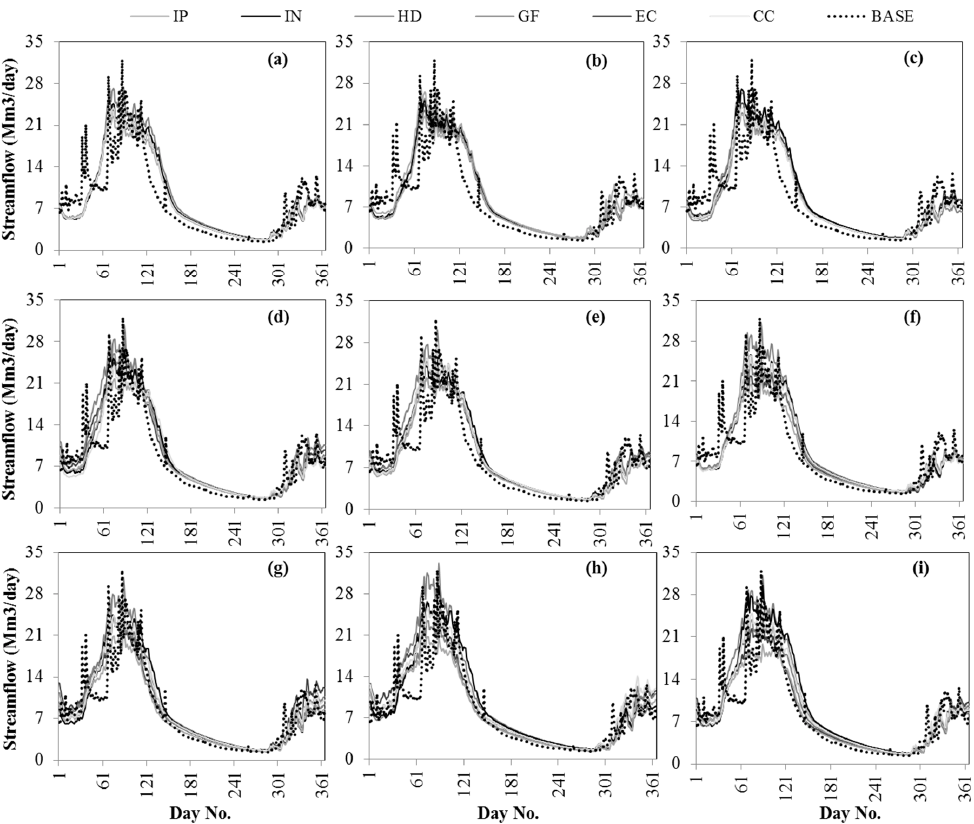
Figure 7. The annual pattern of observed streamflow (dotted graph) and future projected streamflows of SUB- 3. ( a ): A1B-2020s; ( b ): A2-2020s; ( c ): B1-2020s; ( d ): A1B-2050s; ( e ): A2-2050s; ( f ): B1-2050s; ( g ): A1B-2080s; ( h ): A2-2080s; ( i ): B1-2080s.